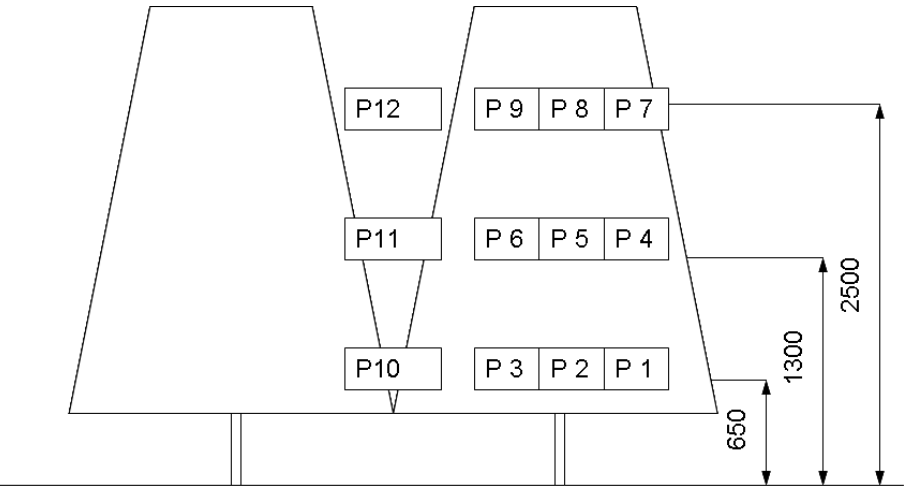
Figure 7. Sampling positions on the tree and between